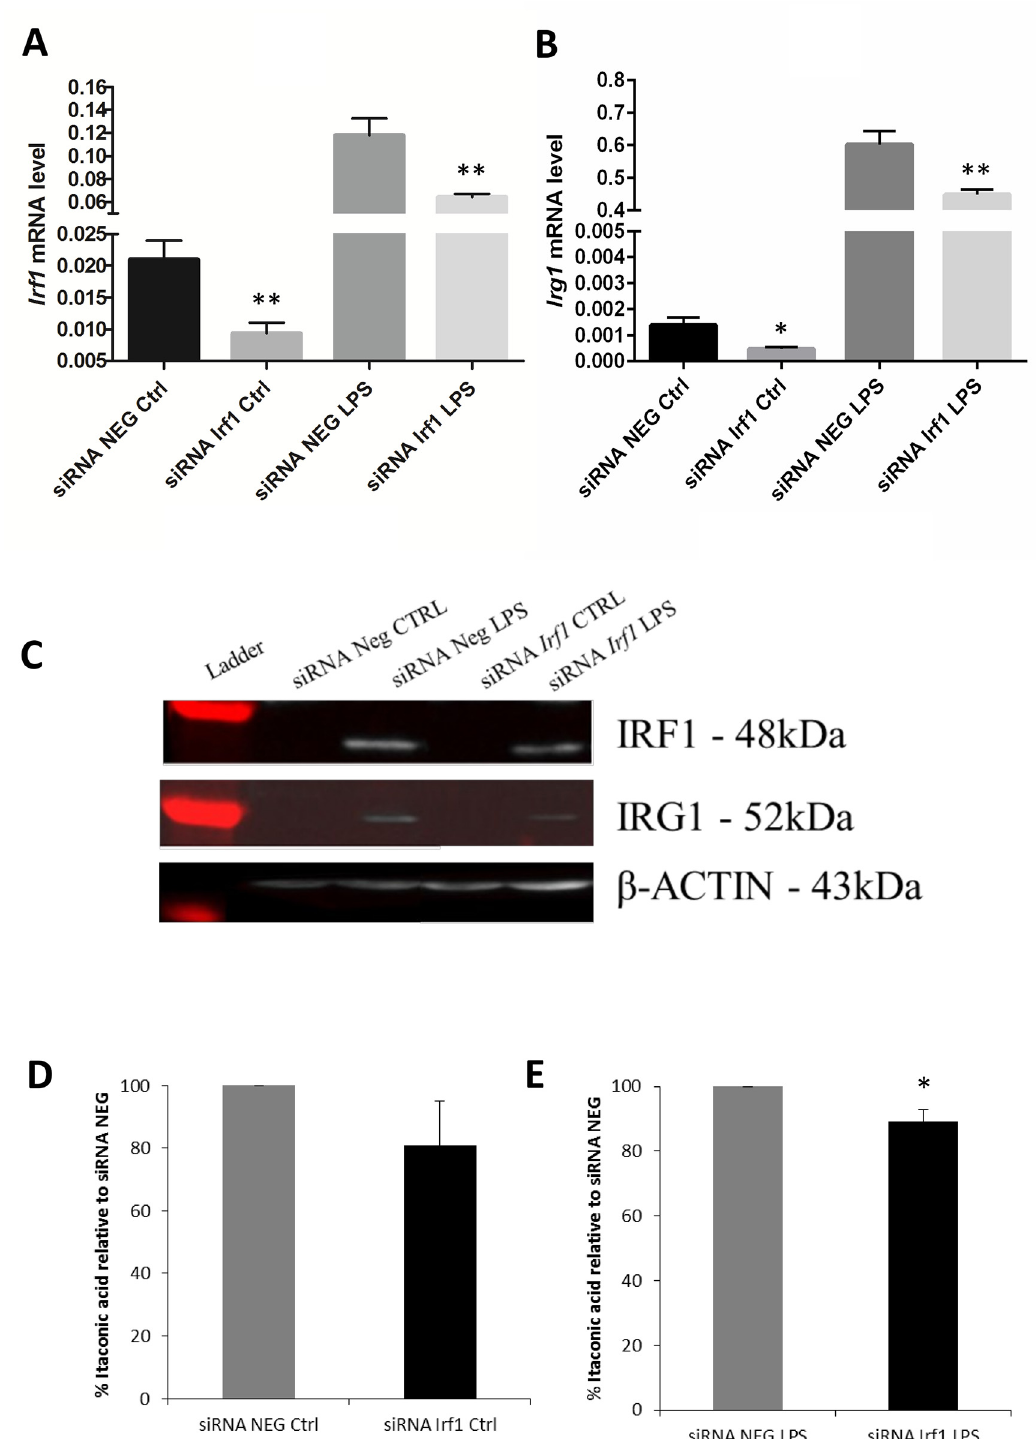
Fig 6. siRNA Irf1 mediated gene silencing in mouse RAW264.7 macrophages. ( A, B ) RAW264.7 cells were transfected with siRNA negative (siRNA NEG) or siRNA specific to Irf1 (siRNA Irf1) 24 hours before treatment and RNA was extracted 2 hours after activation with LPS (10ng/ml). The bars show the mean of 3 biological replicates ( ± SEM) of ( A ) Irf1 and ( B ) Irg1 mRNA levels measured by real-time PCR normalised with L27 as the housekeeping gene. ** p < 0.01, * p < 0.05. ( C ) Proteins were extracted from transfected cells after 4 hours of LPS stimulation. Western blot bands of IRF1, IRG1/CAD and β - ACTIN proteins are shown. ( D, E ) Metabolites were extracted from transfected cells after 4h of LPS stimulation and analysed by GC-MS. Itaconic acid levels